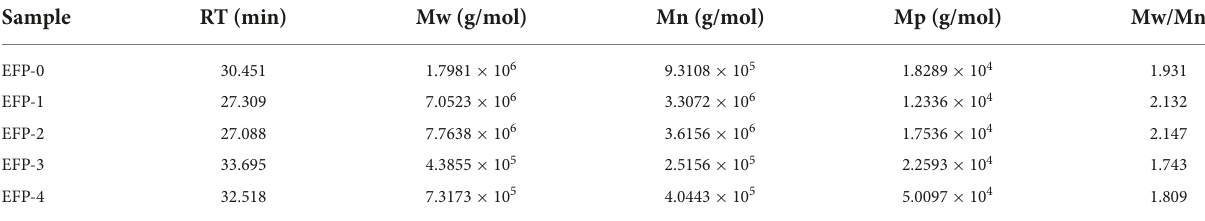
TABLE 2 Composition and percentage of monosaccharides.